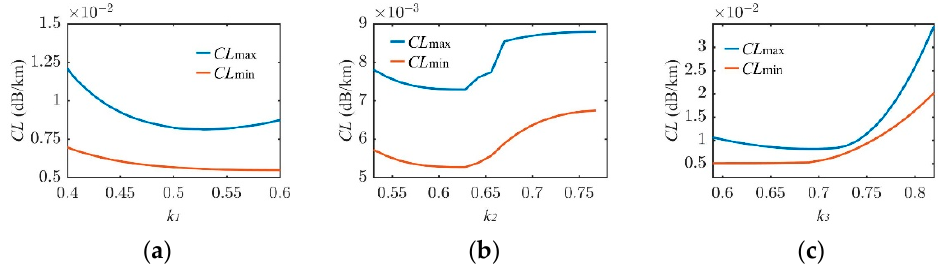
( d ) Figure 5. ( a ) Change in CL with r 1 ; ( b ) Change in CL with r 2 ; ( c ) Change in CL with l ; ( d ) Change in CL with t . The small tube in the nested capillaries enhances the confinement of the core modes [16]. Figure 6 depicts how the ratio k 1 , k 2 , and k 3 changes CL. Several previous studies have computed this [27]. However, in these studies, the nested capillaries at different positions used the same proportion coefficient. Our study found that the nested capillaries at dif- ferent positions reached the minimum CL at different ratios. Figure 6a–c show different